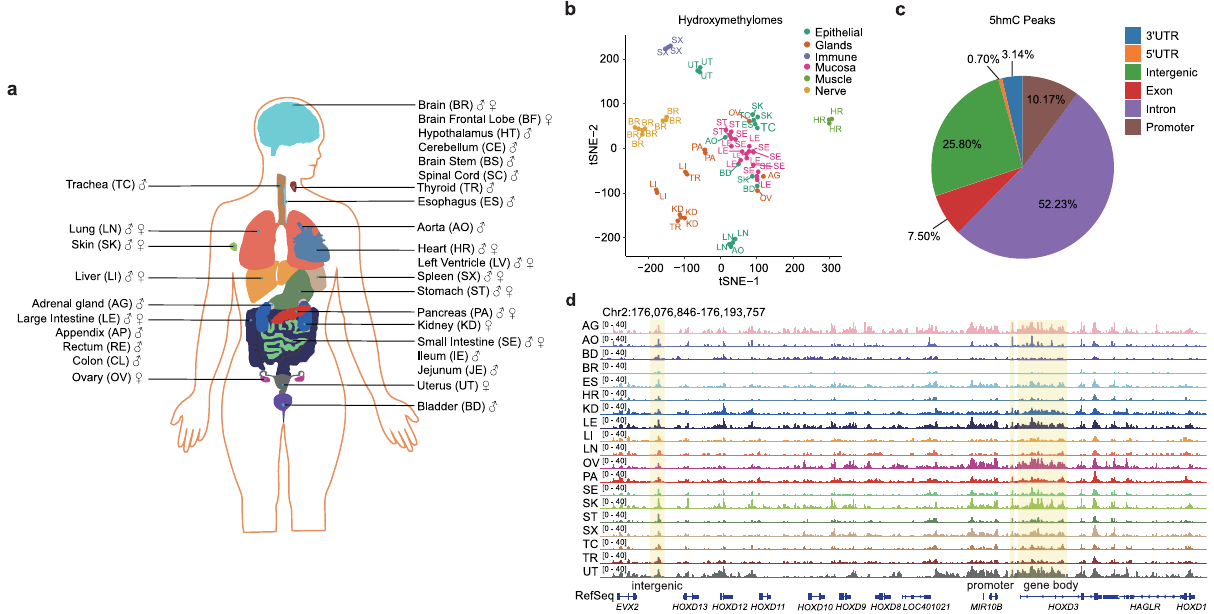
Fig. 1 Hydroxymethylation landscape of human tissues. a Human tissues analyzed in this study. Samples are denoted by the two-letter code in parentheses. Colors indicate each tissue type. b tSNE cluster of all tissues using the global 5hmC signals in 10-kb bins. c Pie chart showing the percentage of 5hmC peaks in each class of genomic features. The promoter regions are de fi ned as 2 kb around the TSS. d IGV visualization of the 5hmC signals surrounding the HOXD gene cluster on chromosome 2. 5hmC signals in promoter, gene body or intergenic region are